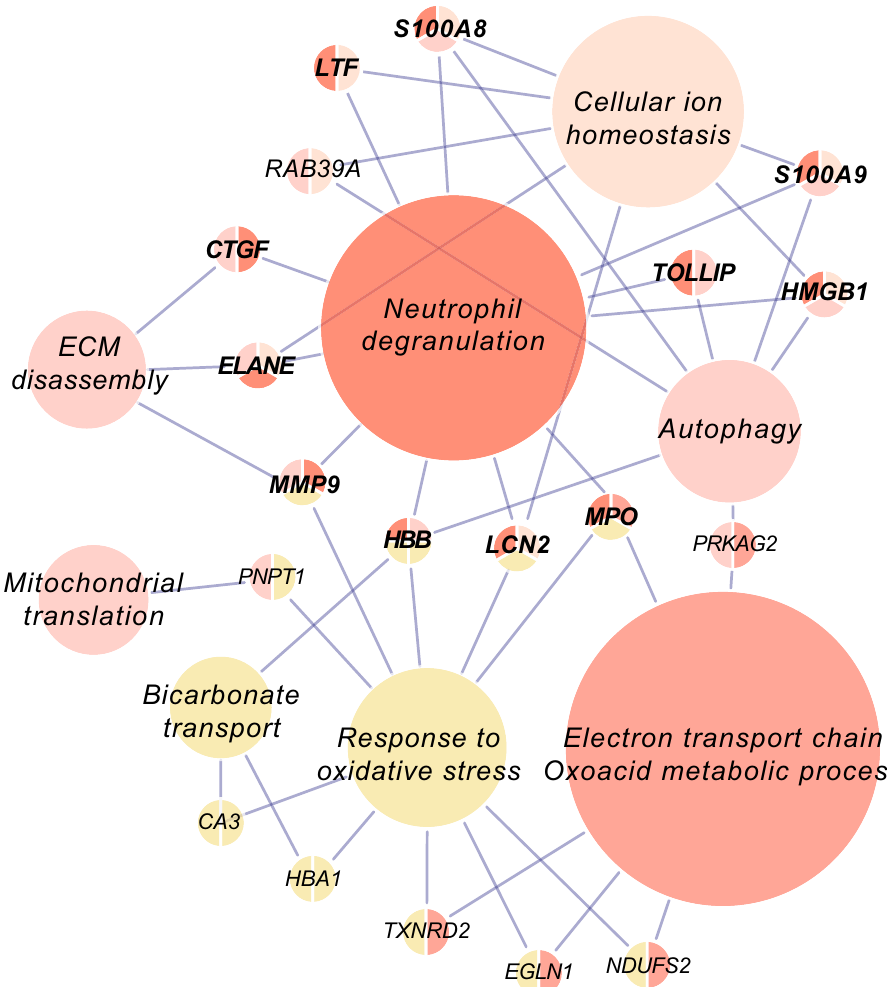
Figure 5. Pivotal proteins interconnecting the up-regulated biological processes in AF. The nodes represent the up-regulated biological processes in AF, and the pivotal proteins that function in multiple processes are shown as gene names . The size of each node represents the number of proteins annotated in it. Note that many of the proteins interconnecting the multiple biological processes are the components of neutrophil degranulation (bold